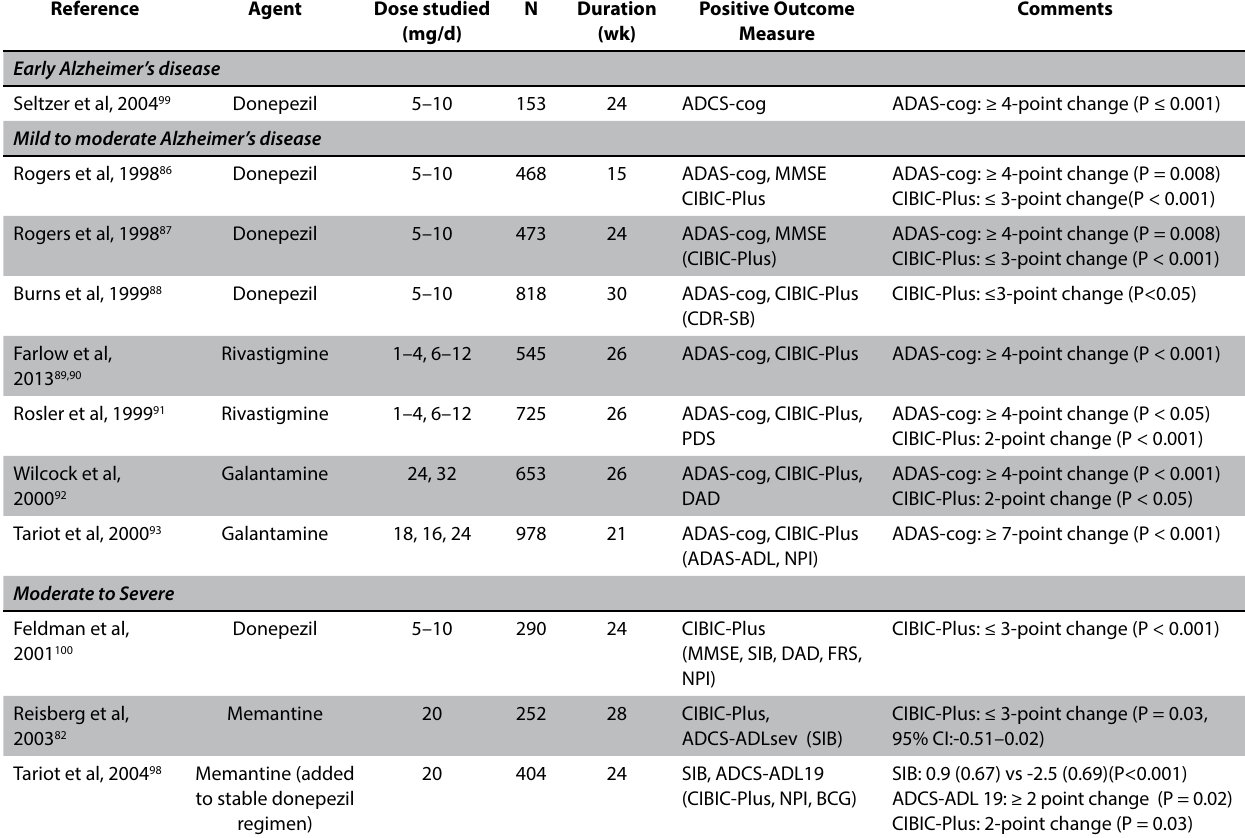
Table V. Evidence relating to pharmacotherapy of cholinesterase inhibitors and NMDA antagonists in improving symptoms of AD 82, 86-93, 98-100